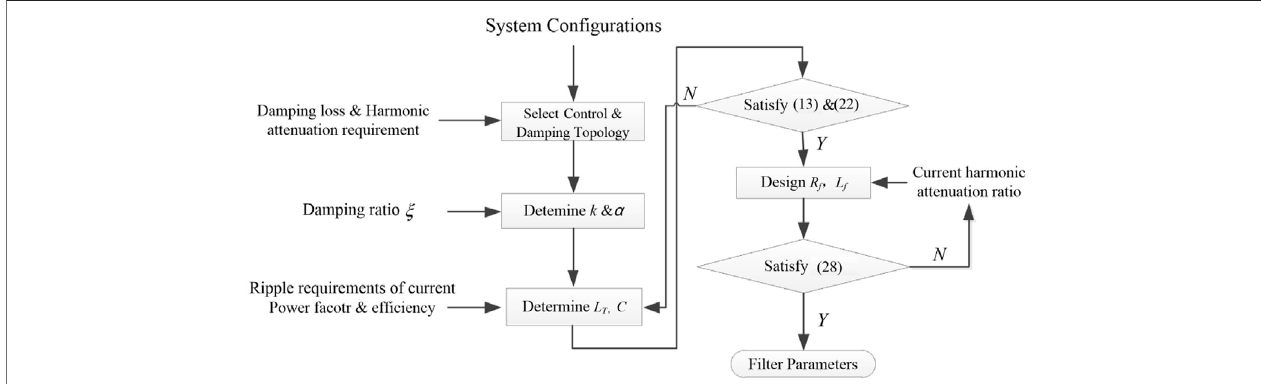
FIGURE 7 | The design process of the LCL fi lter, where Y and N stand for yes and no, respectively.